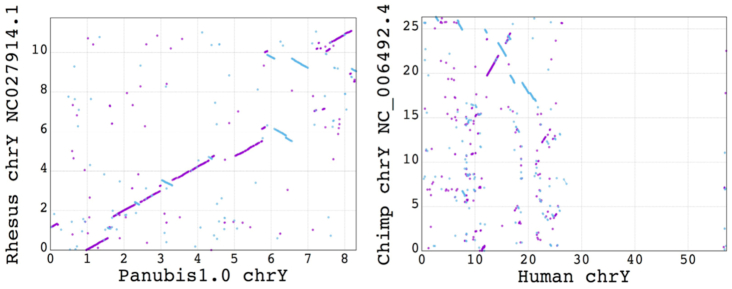
Dot plots showing chromosome Y synteny suggest that the Panubis1.0 chromosome Y is putatively at least a part of the true chromosome Y. A dot plot between rhesus chromosome Y and Panubis1.0 putative chromosome Y is shown on the left, while a dot plot between the chimpanzee chromosome Y and the human chromosome Y is shown on the right. Each dot represents an aligned block, with purple representing an alignment on the positive strand and cyan an alignment on the negative strand. The axis labels are in units of megabases. The phylogenetic distance between baboon and rhesus macaque is similar to that between human and chimpanzee. Hence, the broadly conserved synteny between the rhesus and baboon putative chromosome Y as compared to the synteny between the chimp and human chromosome Y suggests that the scaffold representing the putative chromosome Y in the Panubis1.0 assembly is indeed capturing at least a large part of chromosome Y.